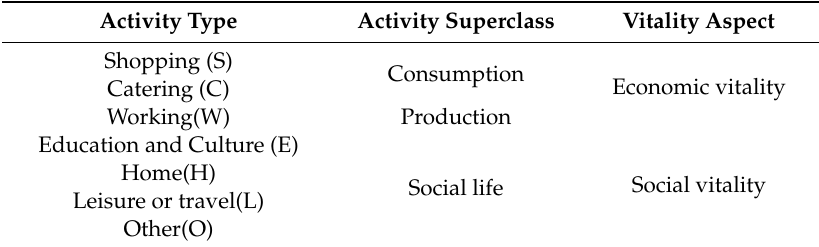
Table 2. Mapping relations between activity types and urban vitality